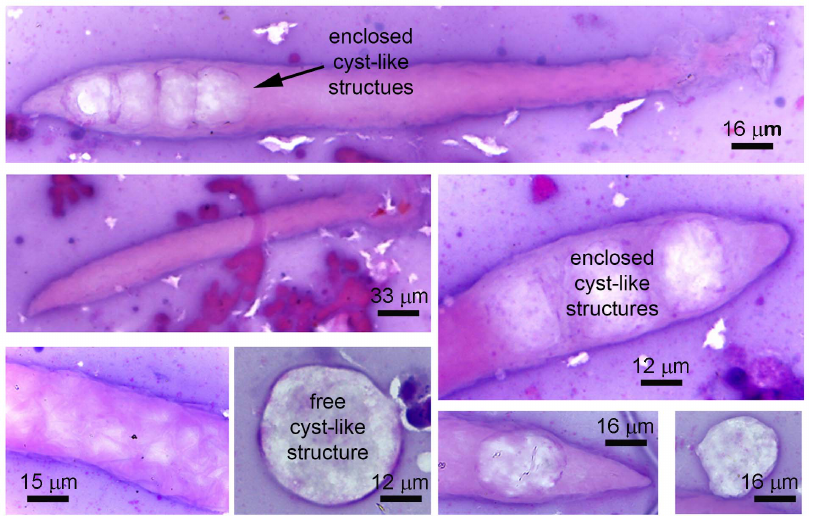
Figure 3. HP tissue smear stained with hematoxylin and eosin to reveal ATM. The photomicrographs clearly show the vermiform morphology and the cyst-like contents inside or free.